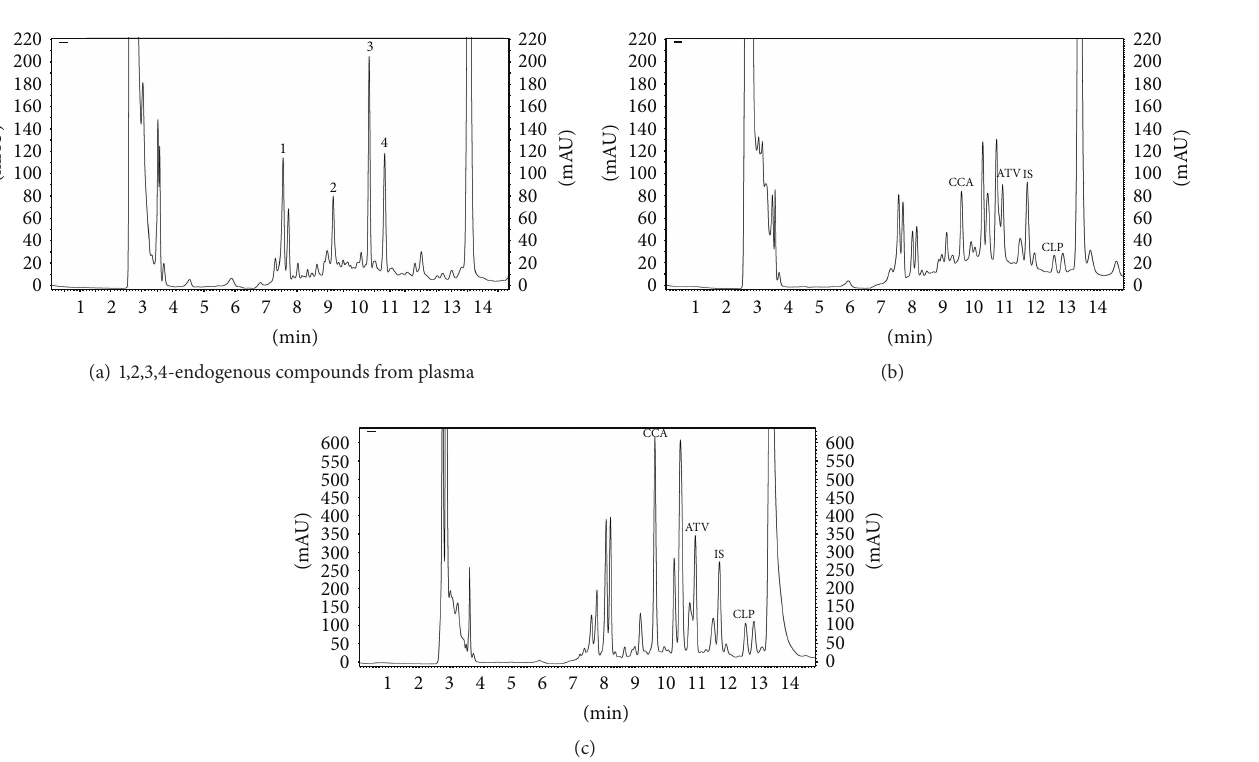
Figure 2: Chromatograms of blank plasma (a); drug-free human plasma spiked with clopidogrel carboxylic acid metabolite (CCA with = 9.663 min), atorvastatin (ATV with 𝑡 𝑡 𝑅 = 12.682 min) (b); plasma sample from a volunteer who received 75 mg clopidogrel and 40mg atorvastatin at 40 minutes after dose under 𝑡 𝑅 optimized gradient method at flow rate of 1mL ⋅ min −1